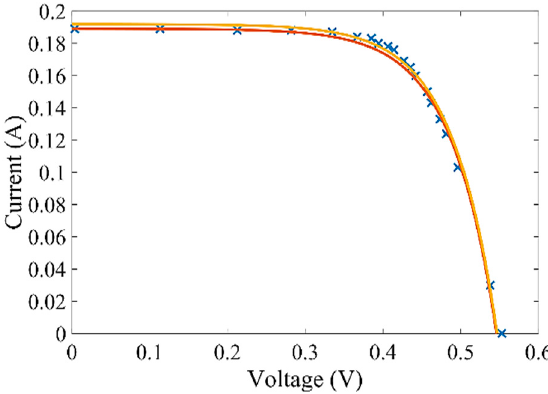
Figure 13. Experimental data acquired ( x ), characteristic curve that approaches the experimental data ( --- ), and simulated characteristic curve ( --- ), for the OG 515 filter.